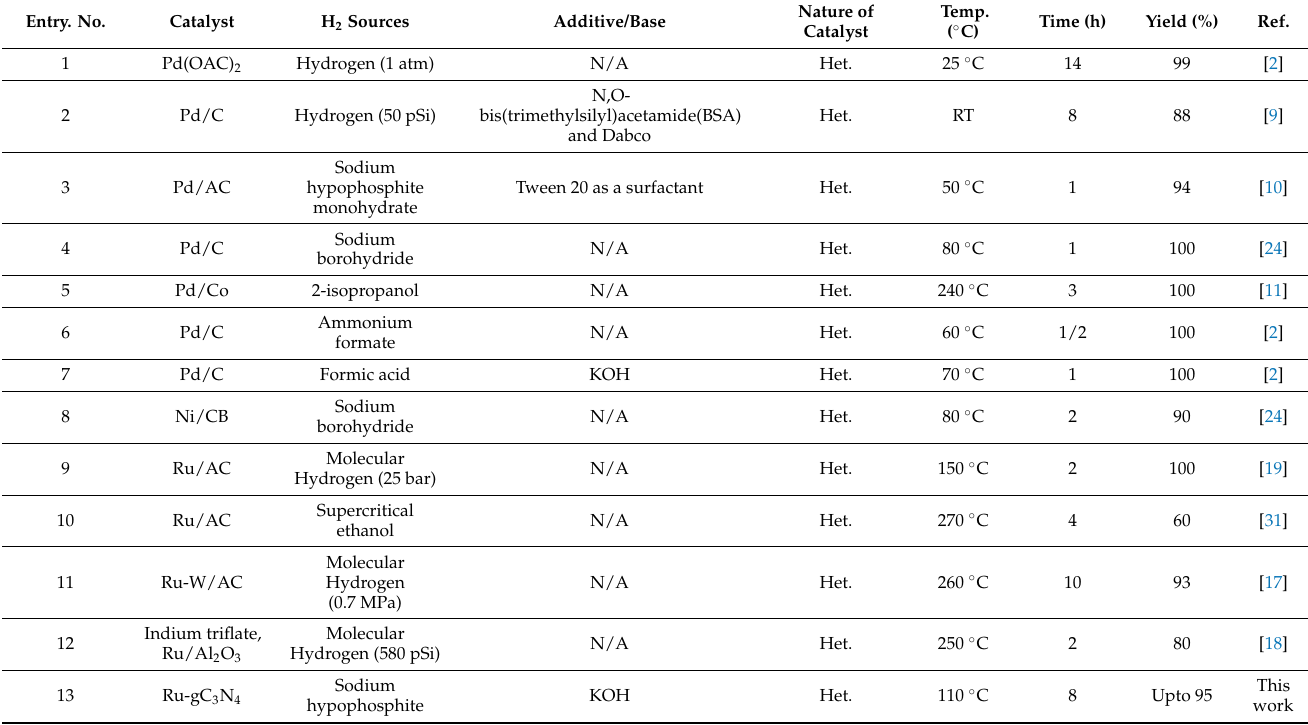
Table 3. Comparison of catalytic activity of Ru-GCN Nanocomposite with other reported catalysts for the Hydrodebenzylation